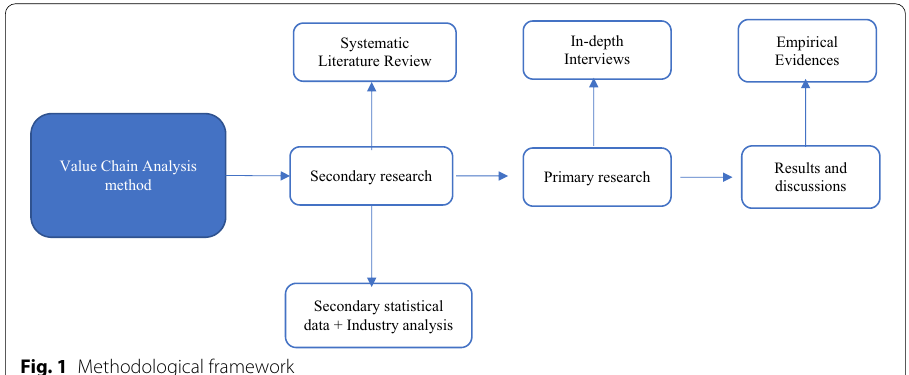
Fig. 1 Methodological